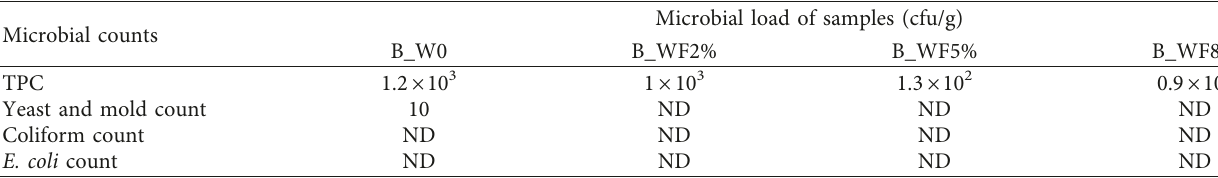
TPC: total plate count; B_W0: 100% wheat flour+0% fenugreek flour; B_WF2%: 98% wheat flour+2% fenugreek flour; B_WF5%: 95% wheat flour+5% fenugreek flour; B_WF8%: 92% wheat flour+8% fenugreek flour; ND: not